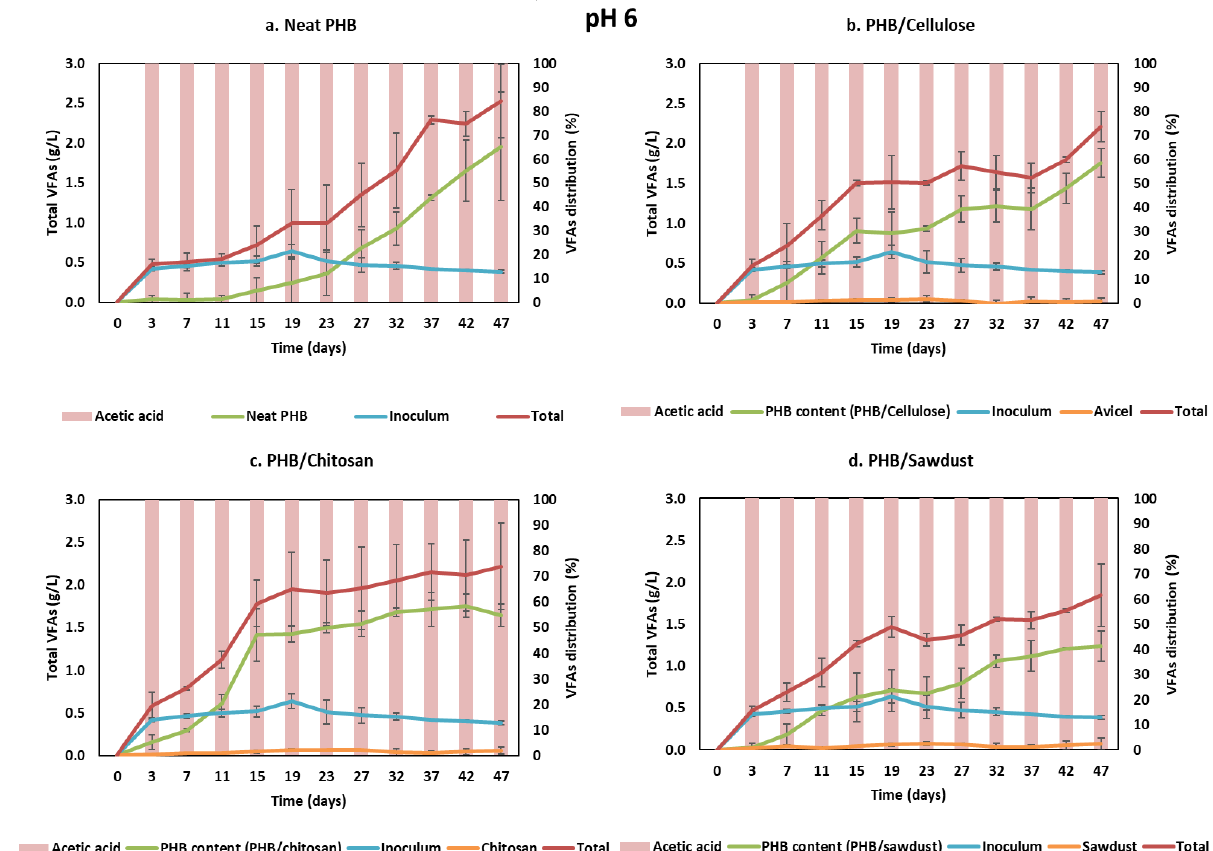
Figure 2. Concentration and percentage distribution of VFAs during acidogenic fermentation of neat PHB ( a ) and PHB composites of PHB/cellulose ( b ), PHB/chitosan ( c ), and PHB/sawdust ( d ) at pH 6.